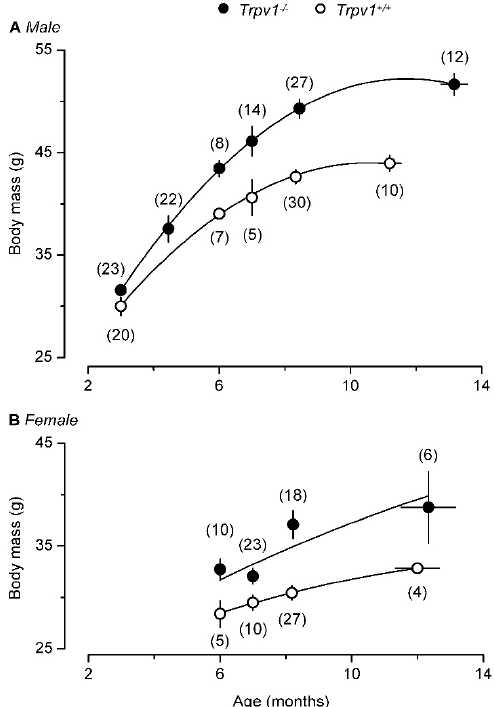
Figure 4. With age, both male ( A ) and female ( B ) TRPV1-null mice become heavier than their age-matched, wild-type controls. Reproduced with permission from [132]. Three studies, three very different outcomes. The genetic background of TRPV1-null mice may be a factor in the discrepant results, along with the age of the animals and the dietary differences. Moreover, it is not easy to reconcile the genetic Trpv1 inactivation studies with the capsaicin desensitization experiments: the first exacerbates aging-associated obesity whereas the second seems to protect against it. One should keep in mind that the TRPV1- null mice lack the capsaicin receptor but have otherwise functional capsaicin-sensitive neurons. By contrast, in the capsaicin-desensitized animals these nerves are non-function- ing. 9. Obesity-Related Changes in Trpv1 Expression As mentioned above, non-neuronal TRPV1 is expressed in fat cells [86]. When rats were kept on HFD, diminished TRPV1 expression was noted both in the white and brown adipose tissue. Human visceral adipose tissue also possesses TRPV1, with markedly re- duced expression in the obese [86]. Morbidly obese men also showed diminished pain and flare response in the capsaicin skin test [120], though it is not completely clear if this re- flects reduced TRPV1 expression or obesity-induced small sensory fiber neuropathy. TRPV1-like immunoreactivity was described in the human GI tract, from the stomach (Figure 5) through the duodenum to the colon [73–75]. In epithelial cells, no difference in